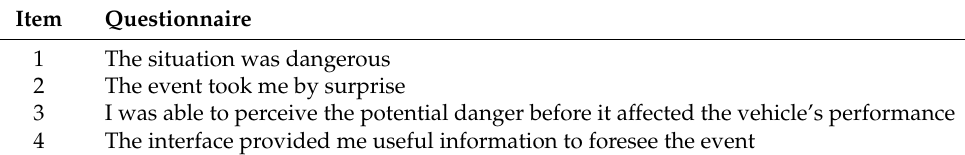
Table 4. Reaction to Events [10]: Questionnaire list.